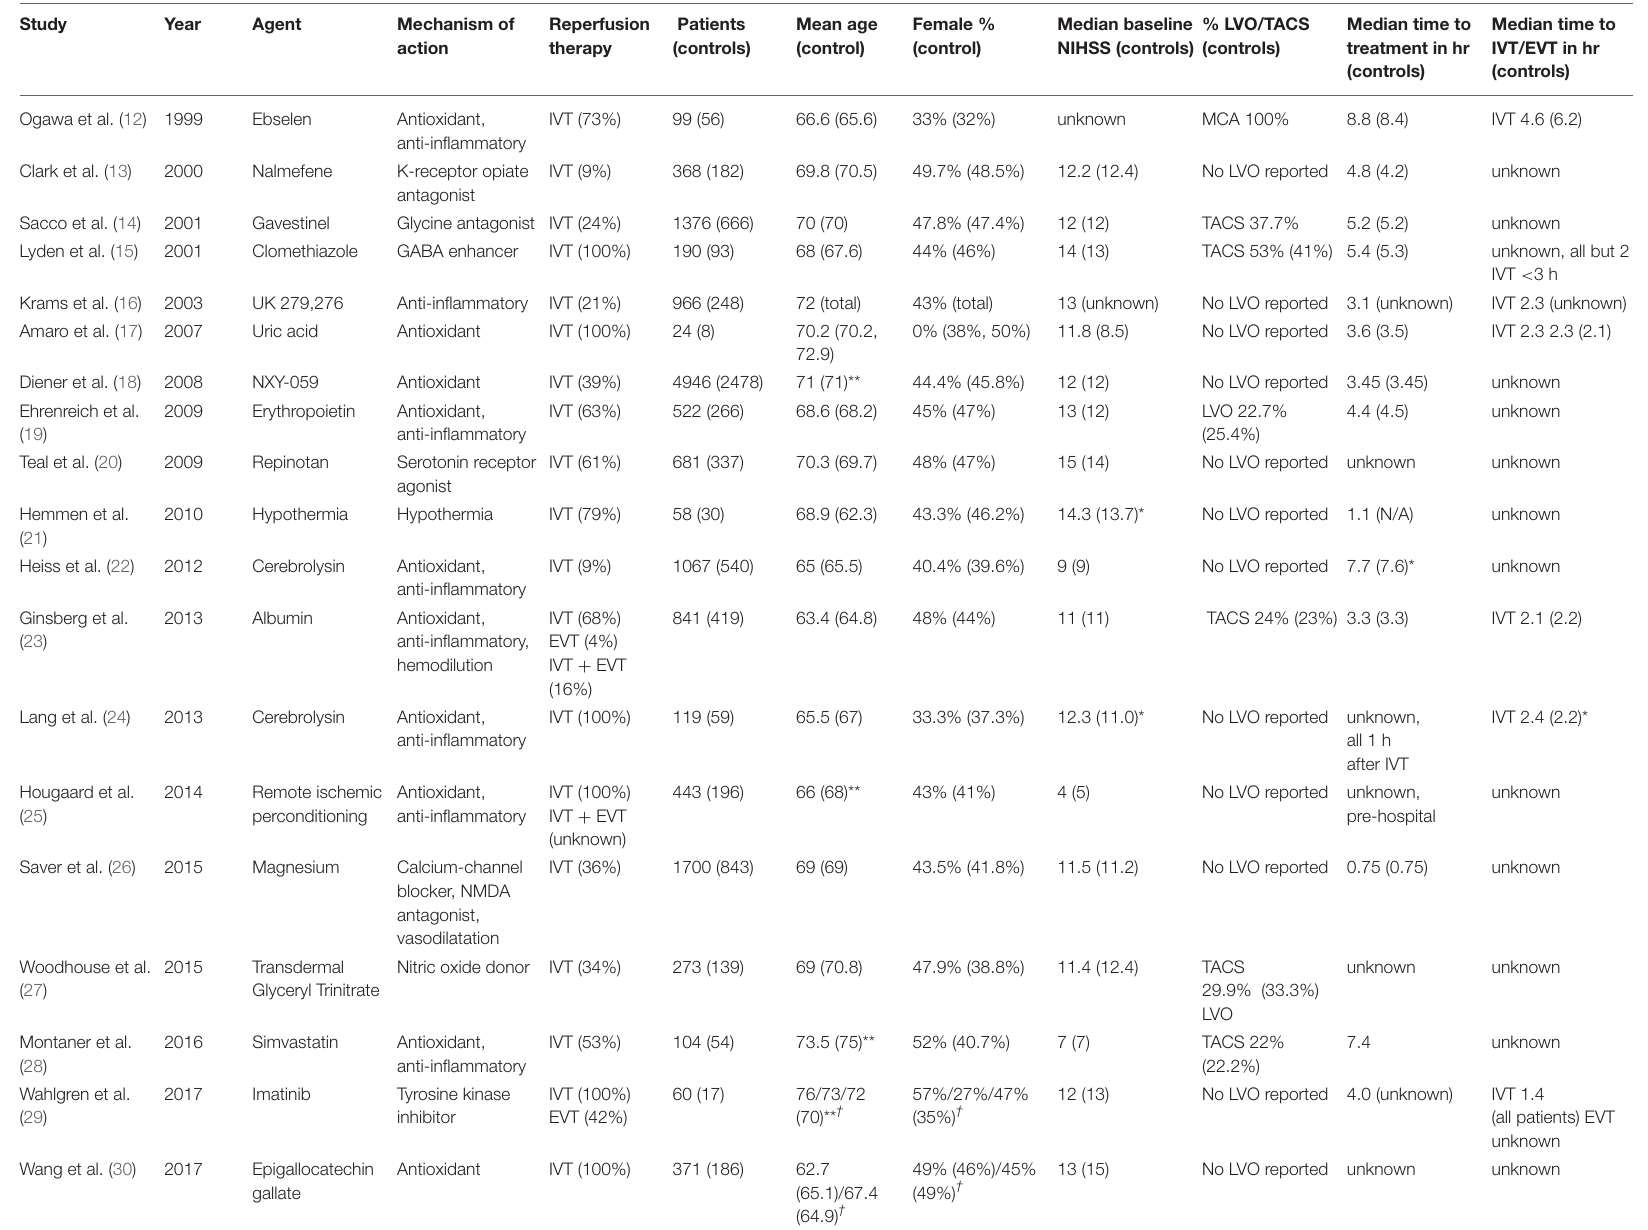
TABLE 1 | Overview of neuroprotective trials using reperfusion